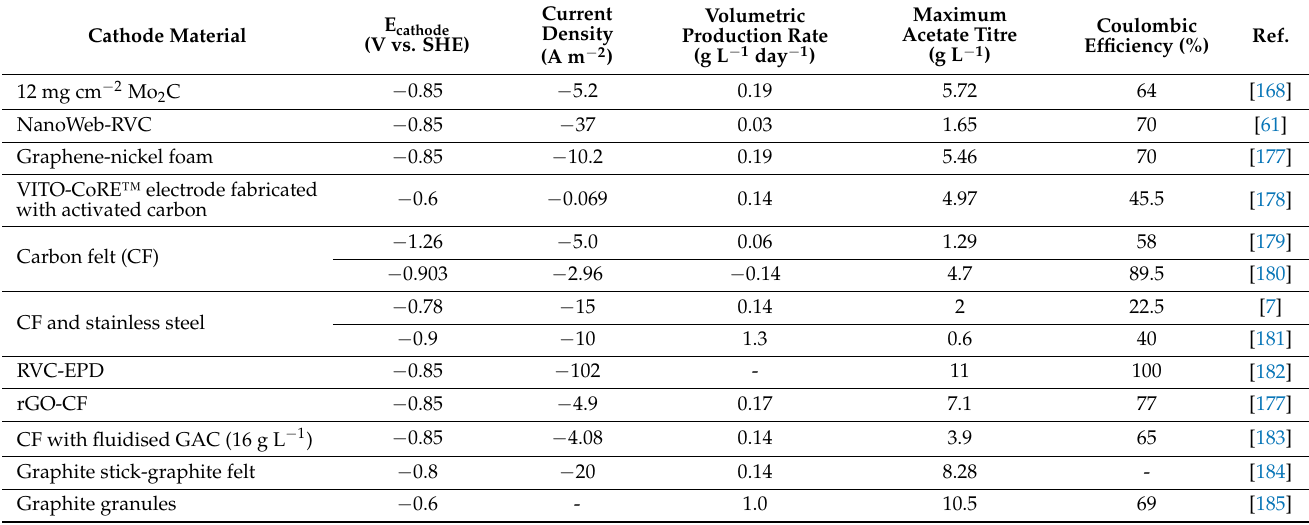
Table 4. Review of literature on the yield of acetate via mixed microbial flora in